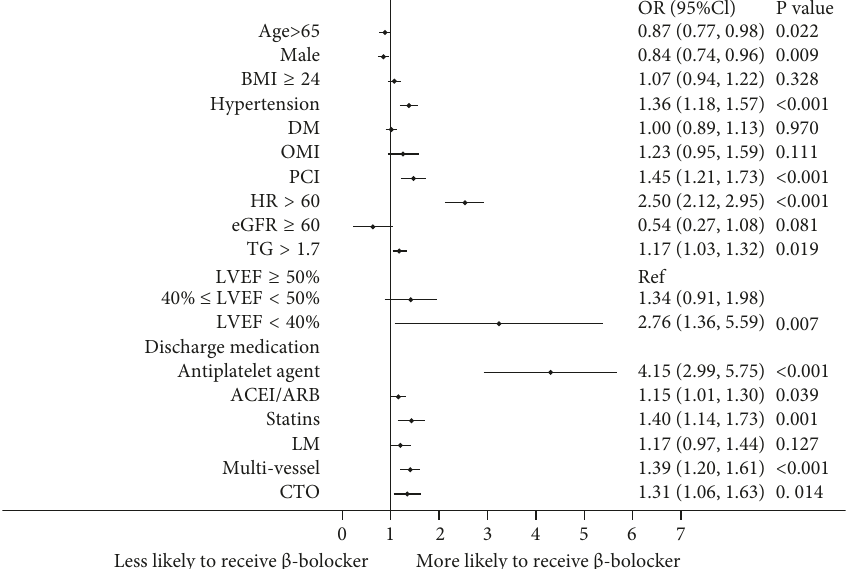
Figure 2: Factors associated with β -blocker use in multivariable analysis. Variables associated with β -blocker use are shown along the vertical axis. The strength of effect is shown along the horizontal axis with the vertical line demarcating an odds ratio (OR) of 1 (i.e., no association); estimates to the right (i.e., 1) are associated with a greater likelihood of β -blocker use, whereas those to the left (i.e., indicate a reduced likelihood of β -blocker use. Each dot represents the point estimate of the effect of that variable in the model, whereas the line shows the 95% confidence interval (CI). BMI, body mass index; DM, diabetes mellitus; OMI, old myocardial infarction; PCI, per- > cutaneous coronary intervention; HR, heart rate; eGFR, estimated glomerular filtration rate; TG, triglyceride; LVEF, left ventricular ejection fraction; LM, left main trunk; CTO, chronic total occlusions; ACEI, angiotensin-converting enzyme inhibitor; ARB, angiotensin II receptor